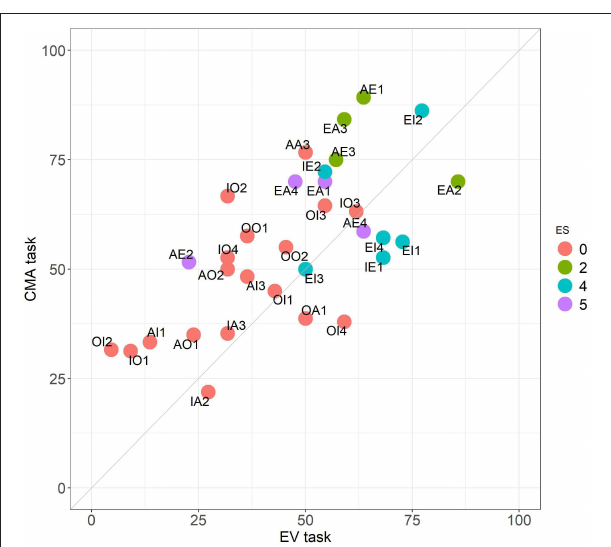
FIGURE 3 | Comparison between the CV and the EV tasks. Performance across the 32 problems. Colors follow the ES classification.